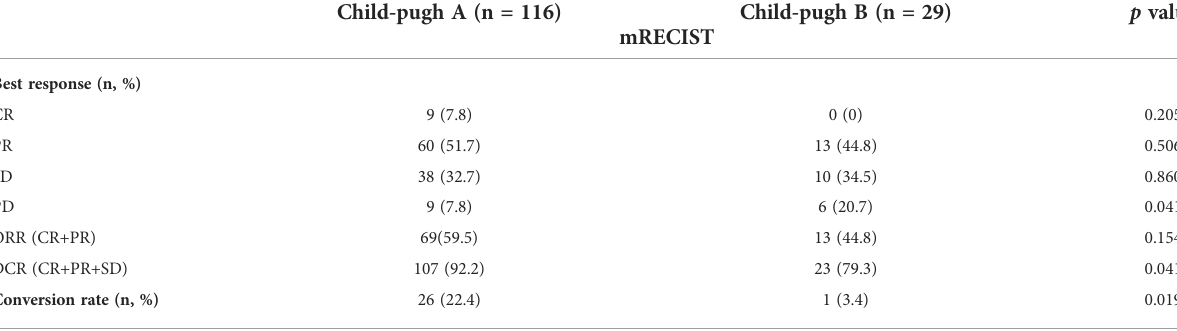
TABLE 3A Subgroup analysis according to liver function (Child-pugh A vs Child-pugh B).